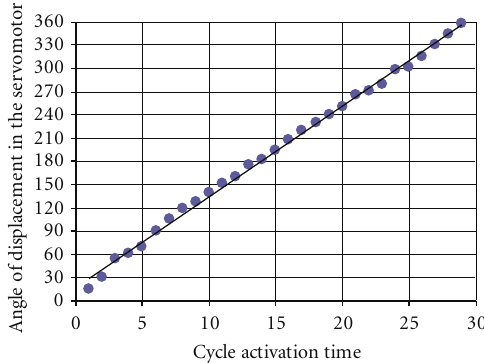
Figure 9: Trajectory for a linear desired position.